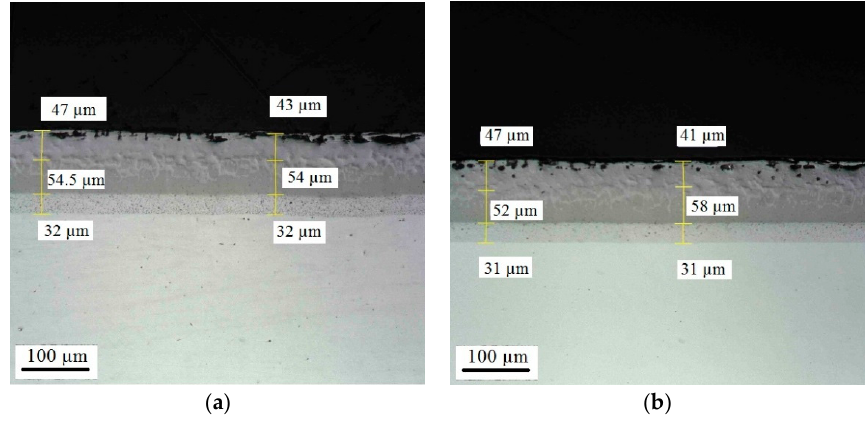
Figure A20. Microscopic images of the cross-section of 316-A-Z ( a ) before and ( b ) after the high-temperature corrosive attack after 168 h.